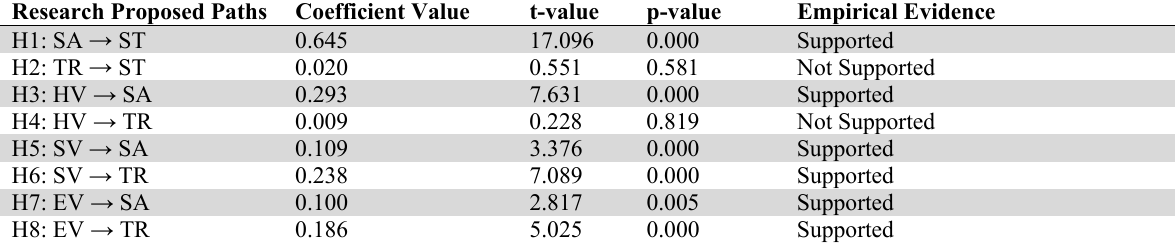
Summary of proposed results for the theoretical model Research Proposed